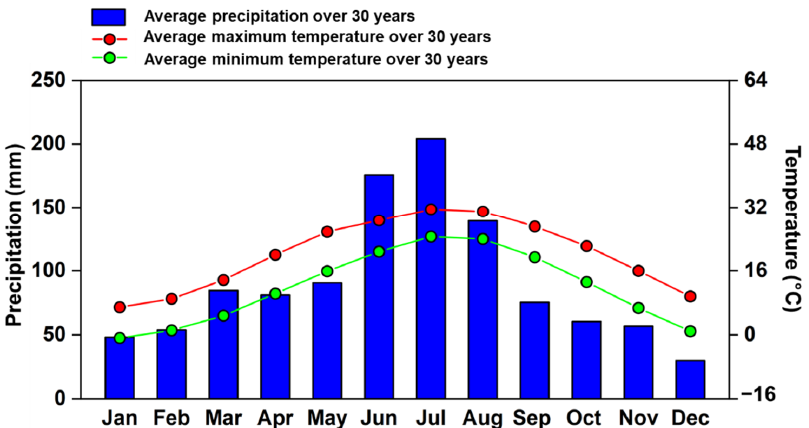
Figure 2. Average precipitation and temperature over 30 years at the experimental site. Data from Chinese Central Meteorological Station. Table 1. The characteristics of the evergreen coniferous forest (ECF) and deciduous broad- leaved forest (DBF) in 2015.